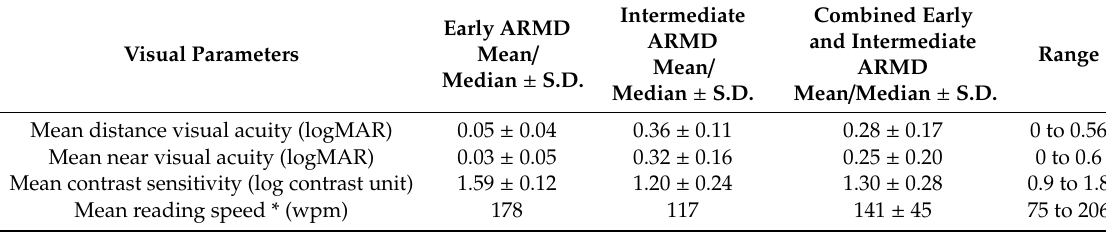
Table 2. Descriptive statistics of visual functions in eyes with early and intermediate